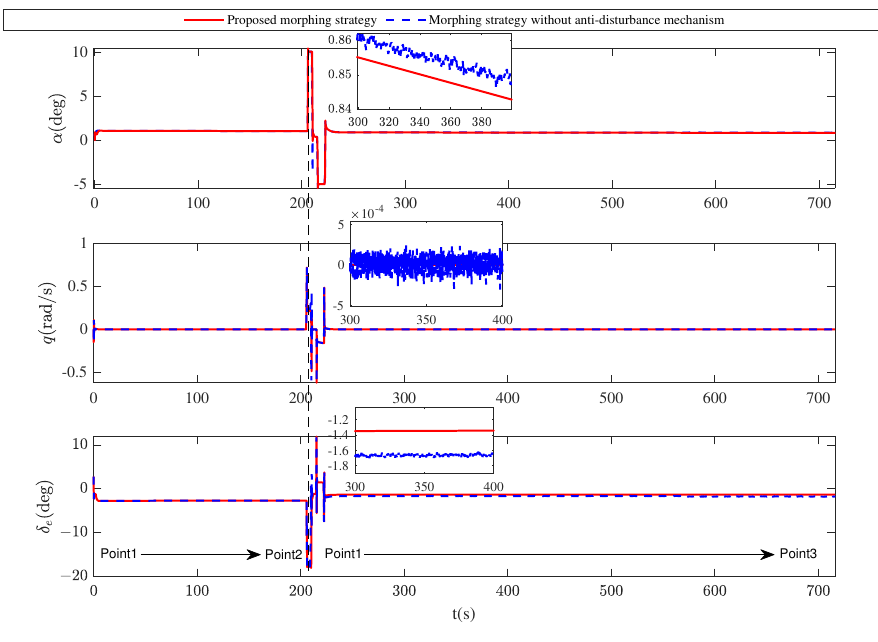
Figure 24. α , q , and δ e of the comparative simulation in Section